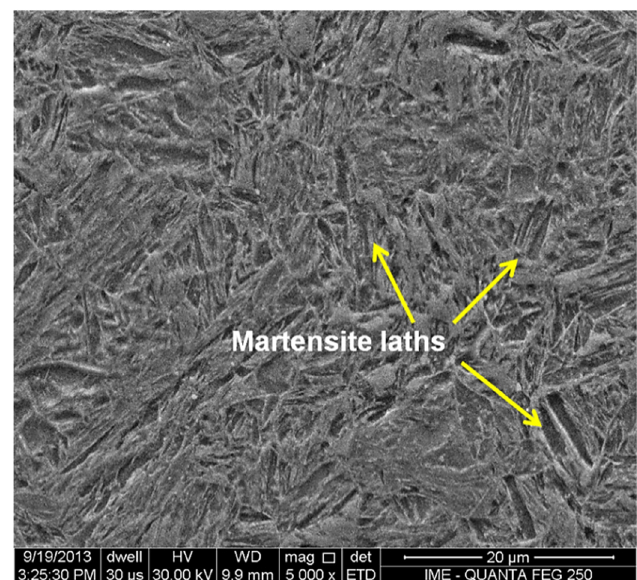
Figure 8 . SEM micrograph of the base metal. Figure 8. SEM micrograph of the base metal.